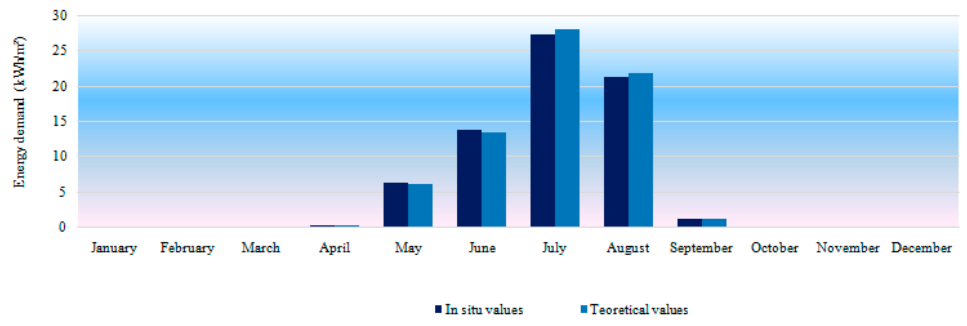
Figure 7. Monthly cooling energy demand according to EnergyPlus.